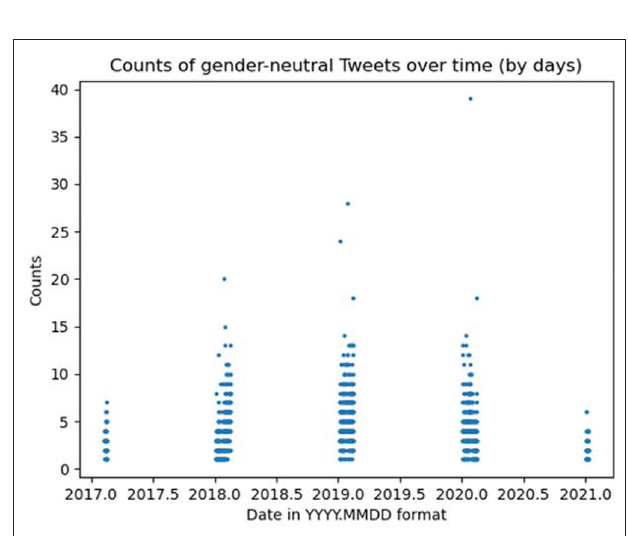
FIGURE 3 | Frequency of gender-neutral usage by day in